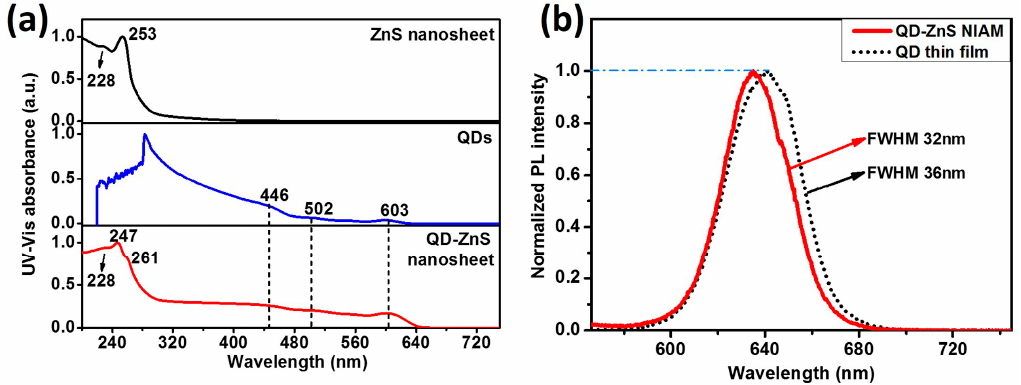
Figure 2. ( a ) Ultra-violet-visible (UV-Vis) absorption spectra of ZnS nanosheet (powder), QDs (solution) and QD-ZnS nanosheet; ( b ) Normalized photoluminescence (PL) emission spectra of QD-ZnS NIAM and QD thin film (excited by a 440 nm laser).